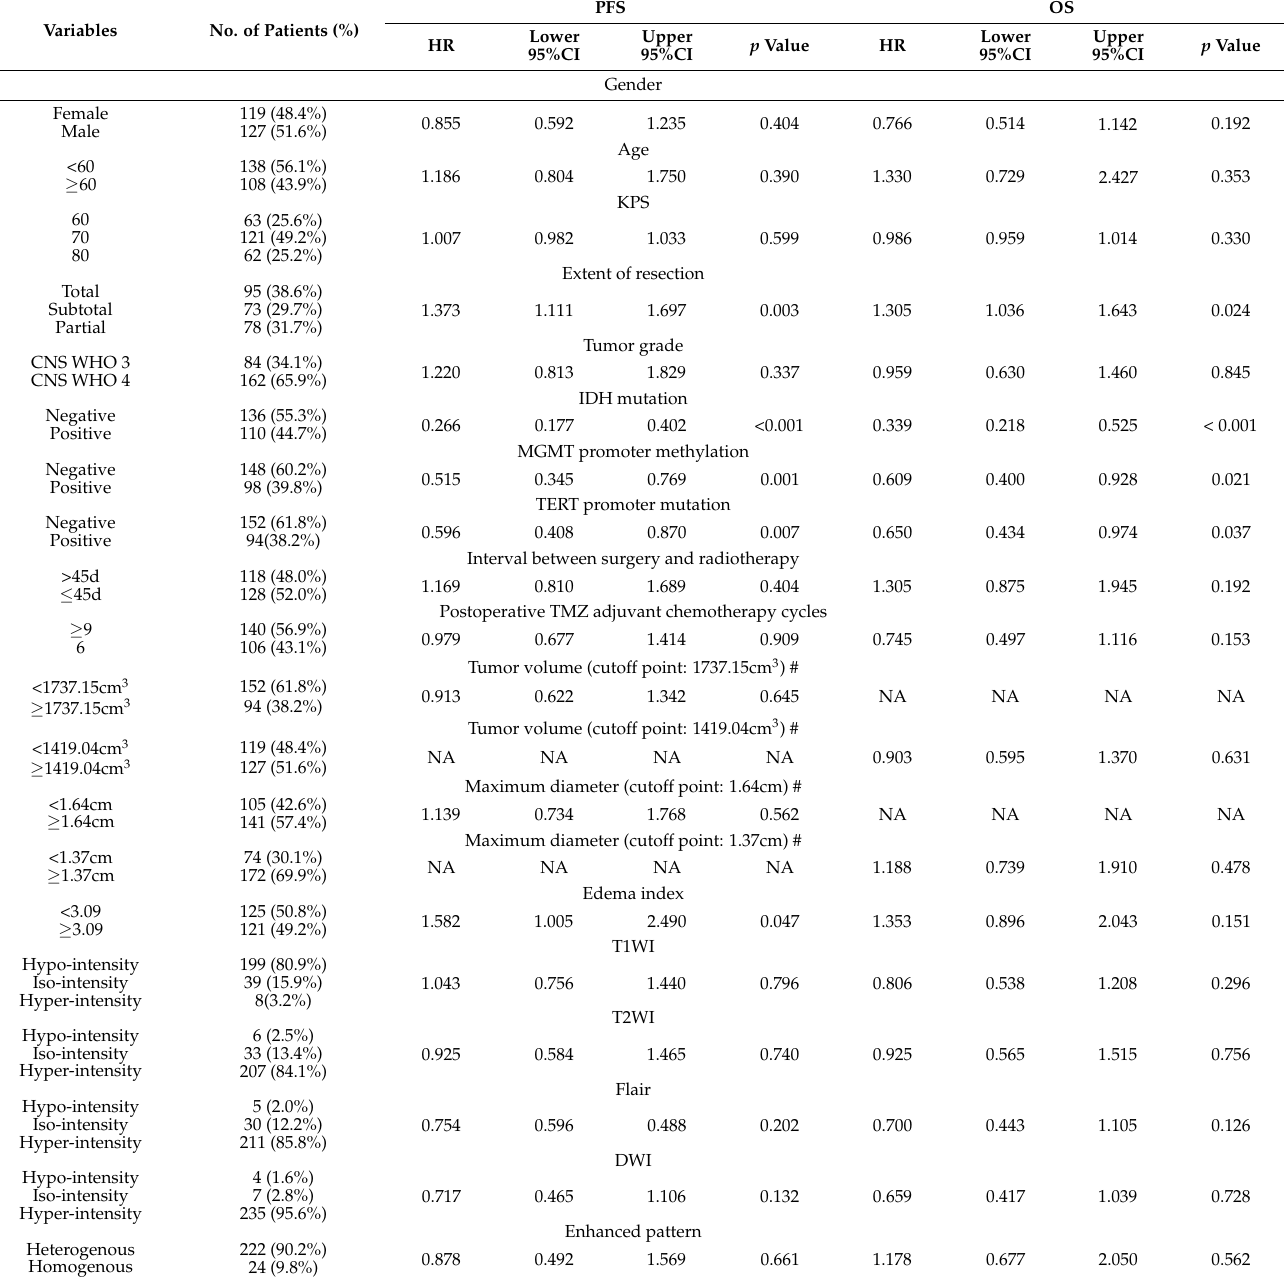
Table 1. Baseline characteristics and results of univariate COX analyses for PFS and